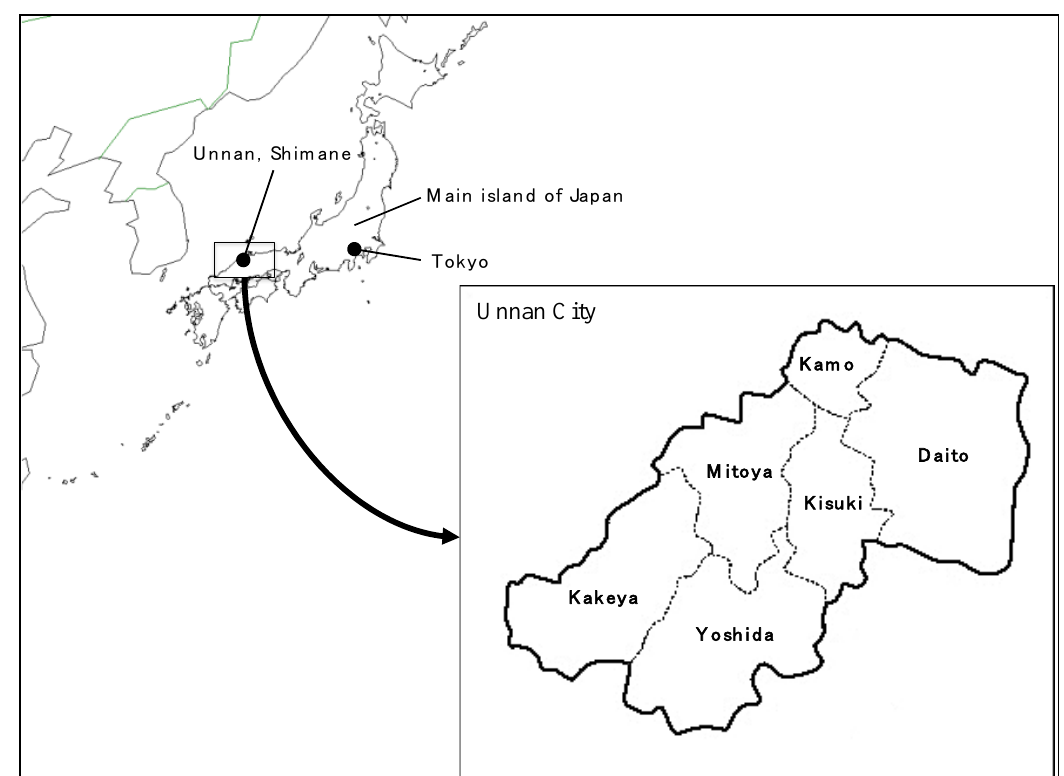
Figure 1. Location of Unnan city and districts.